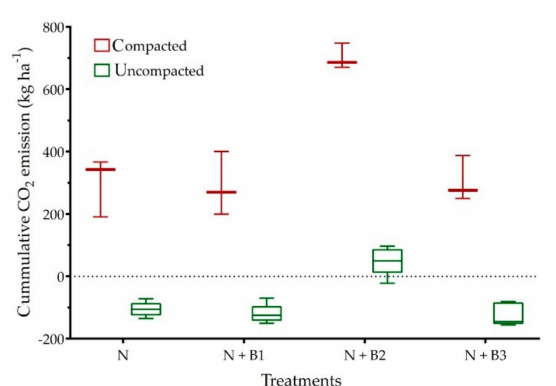
Figure 3. Cumulative CO 2 emissions, box plots show median, percentiles, error bars confidence inter-